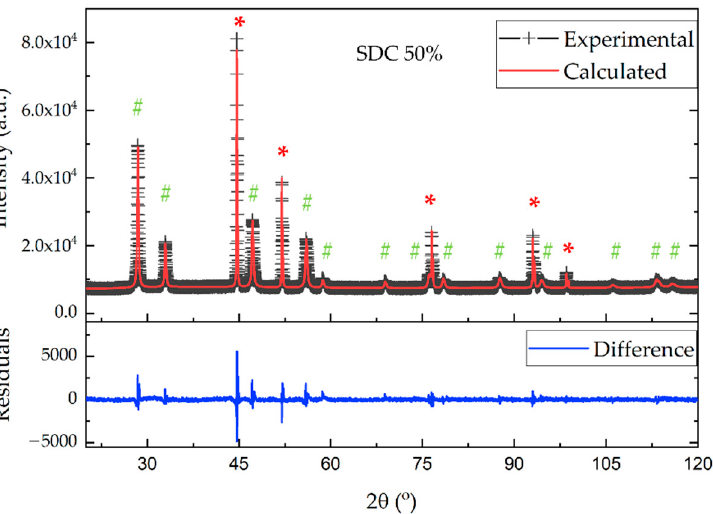
Figure 10. Fitted X-ray diffraction profiles for 50% SDC. Observed (+black symbols), calculated (red line), and difference (blue line, lower) profiles are shown. Reflection positions of Ni and SDC phases are indicated by red “*” and green “#” symbols, respectively.